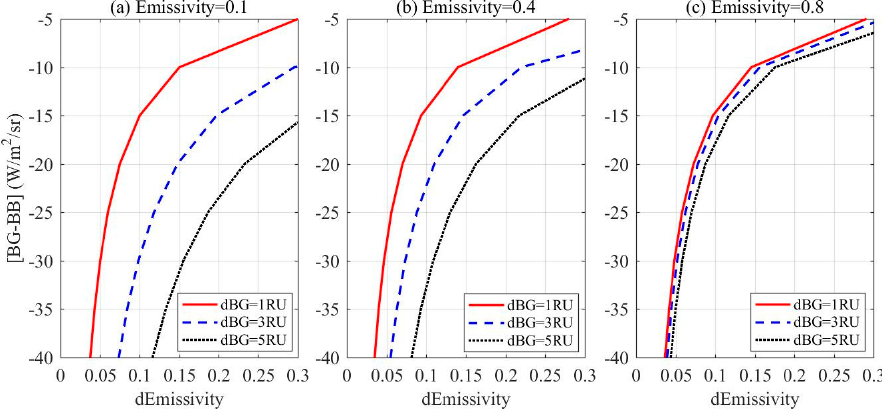
Figure 3. The overall uncertainty under different cloud effective emissivities.